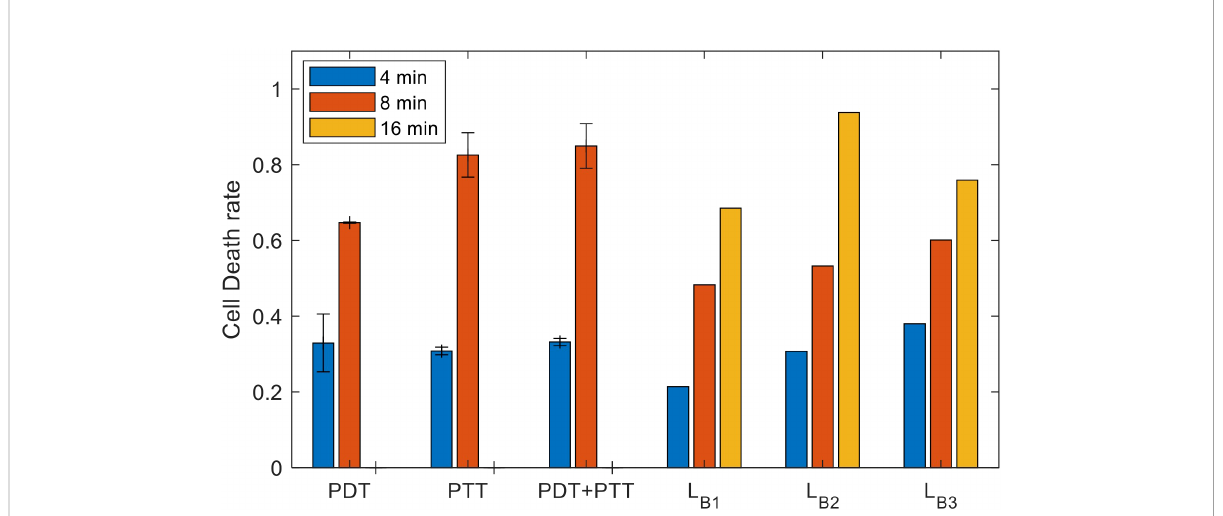
FIGURE 10 Experimental results for the sets of experiments with treatment durations of 4, 8, and 16 minutes (mean and inter-session standard deviation); estimated lower bounds for the outcome of combined treatment at durations of 4, 8, and 16